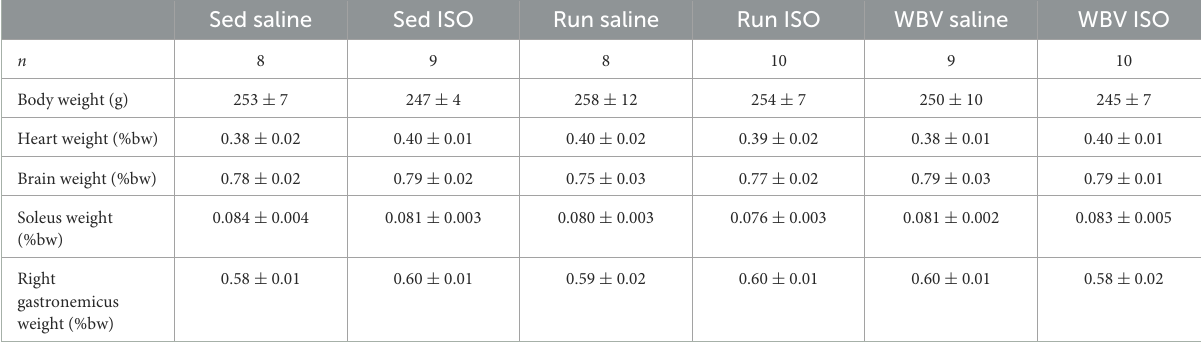
TABLE 1 Body weight (bw) and relative organ weights before killing in the different experimental groups.